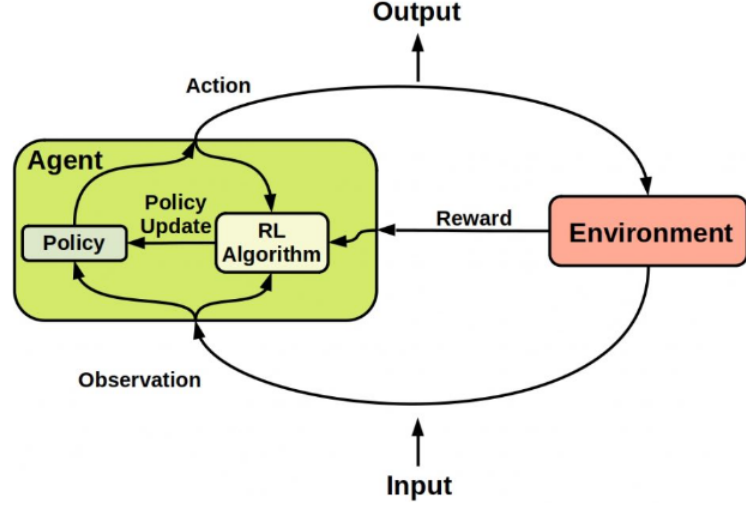
Figure 2. Reinforcement Learning